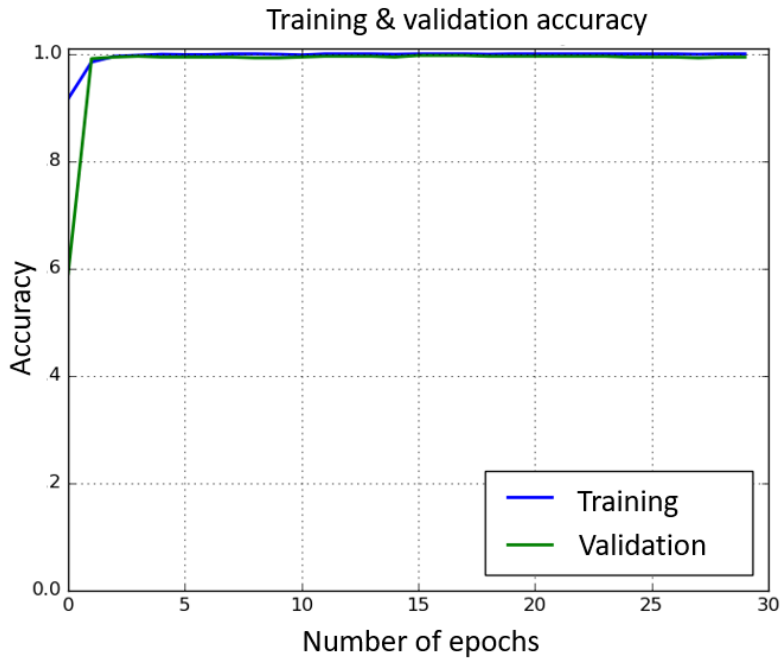
Figure 5. Training (blue) and validation (green) accuracy through epochs for the